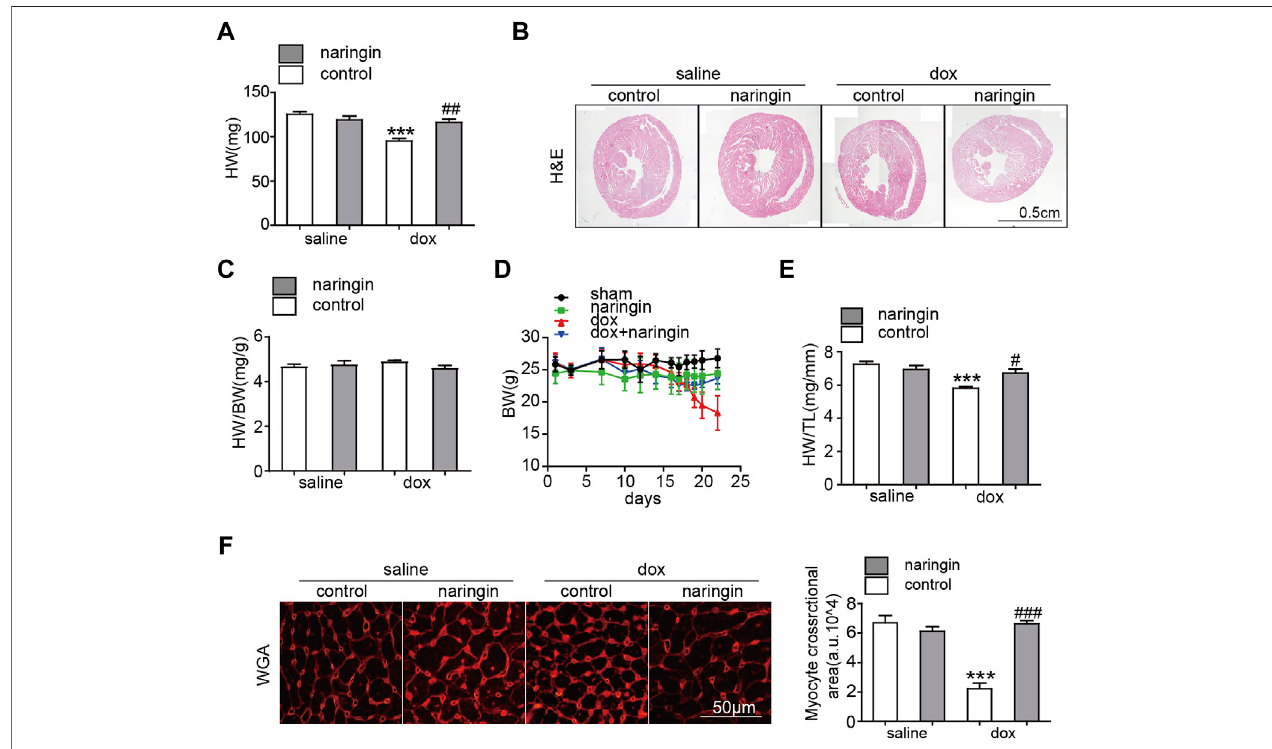
FIGURE 2 | Naringin inhibits the effect of DOX on myocardial atrophy in vivo . (A) Heart weight of four groups. (B) H&E staining of heart sections (Scale bar 1,500 μ m). (C) Effect of NR on the ratios of heart weight to body weight (HW/BW). (D) Body weight of four groups. (E) Effect of NR on the ratios of heart weight to tibia length(HW/TL). (F) Heartcross-sectionswerestainedwithWGA,(left panel).Quanti fi cation oftherelativemyocyte cross-sectionalareawithquanti fi cationanalysis(right panel). *** p < 0.001 DOX versus control group; # p < 0.05, ## p < 0.01, and ### p < 0.001 DOX versus NR +